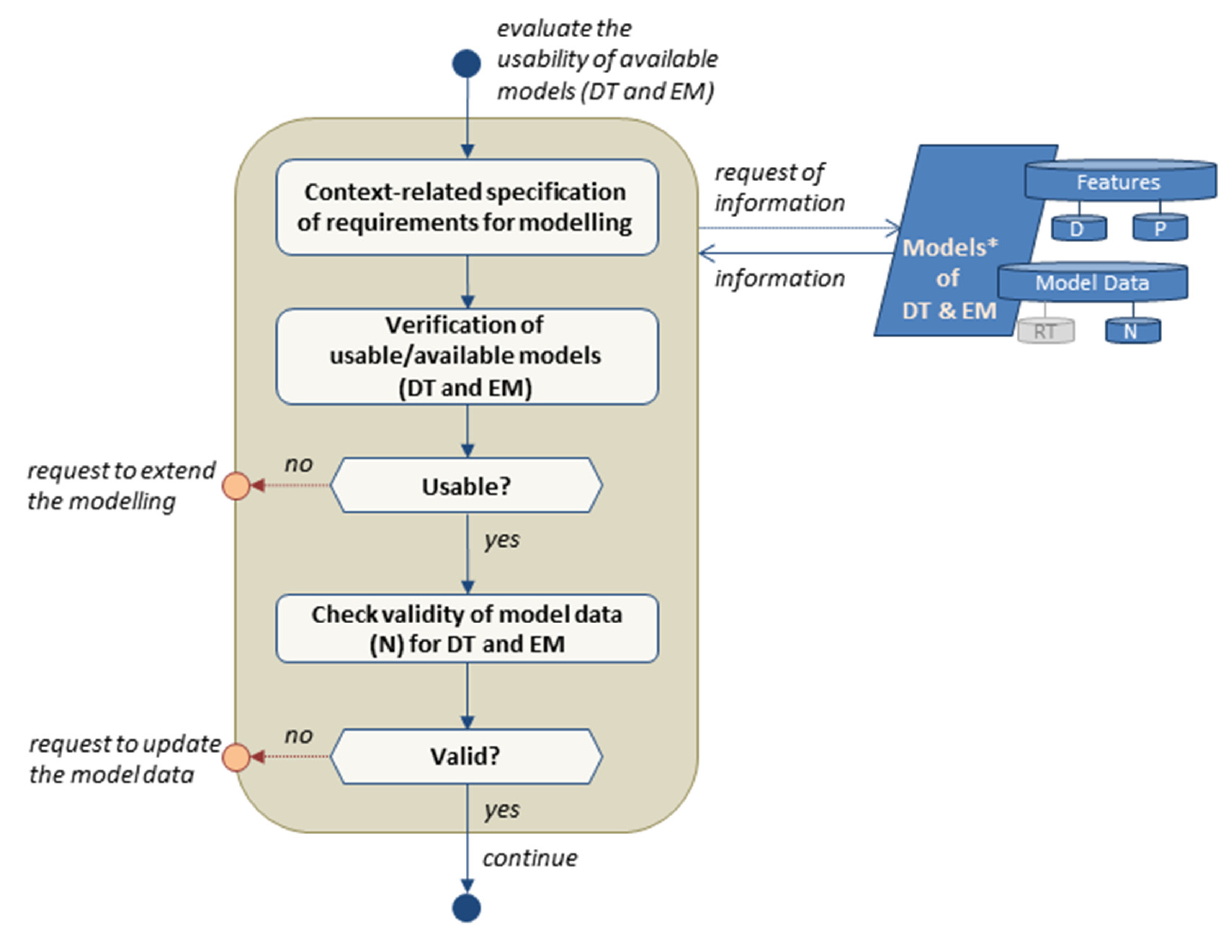
Figure 5. Flow chart of DT and EM model evaluation as a function of context specification.